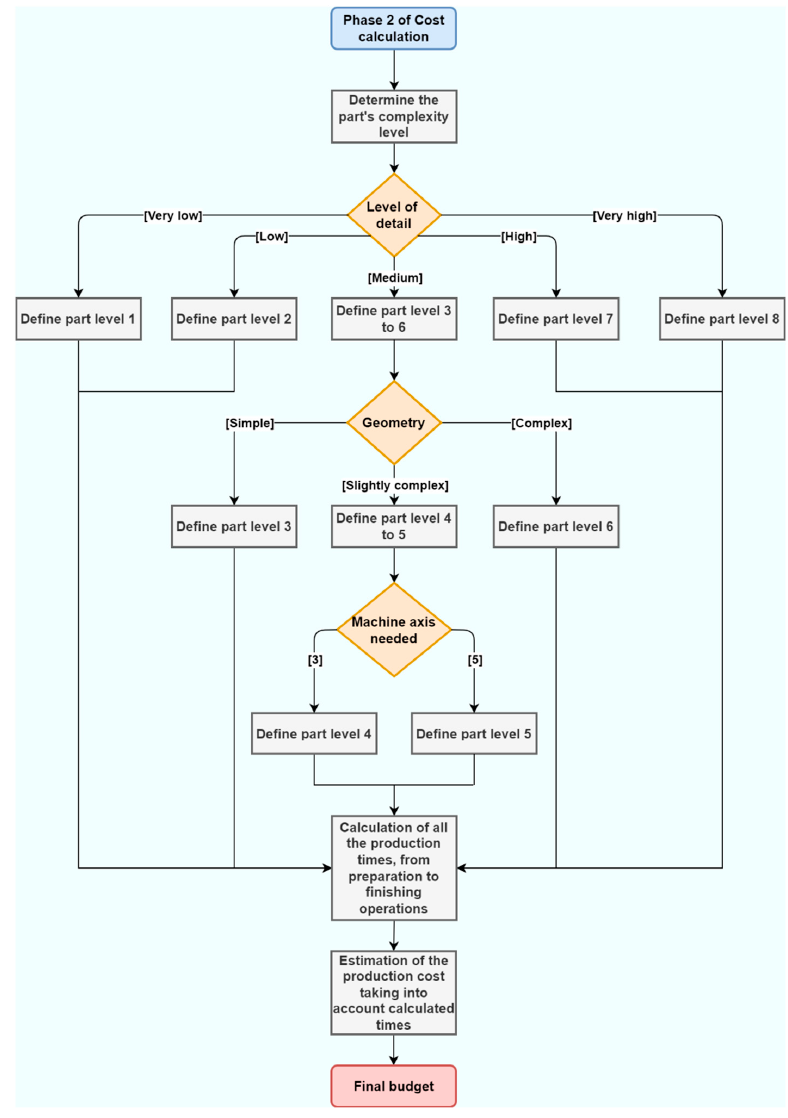
Figure 6. Flow chart of the developed model, for the second cost calculation step.